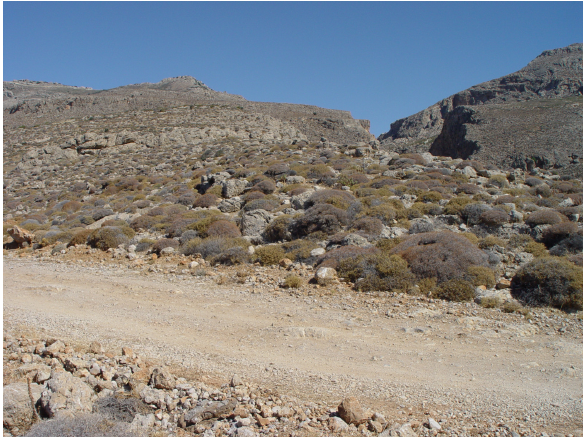
Figure 3. Livari Cheromylia, view from the south (photo by the